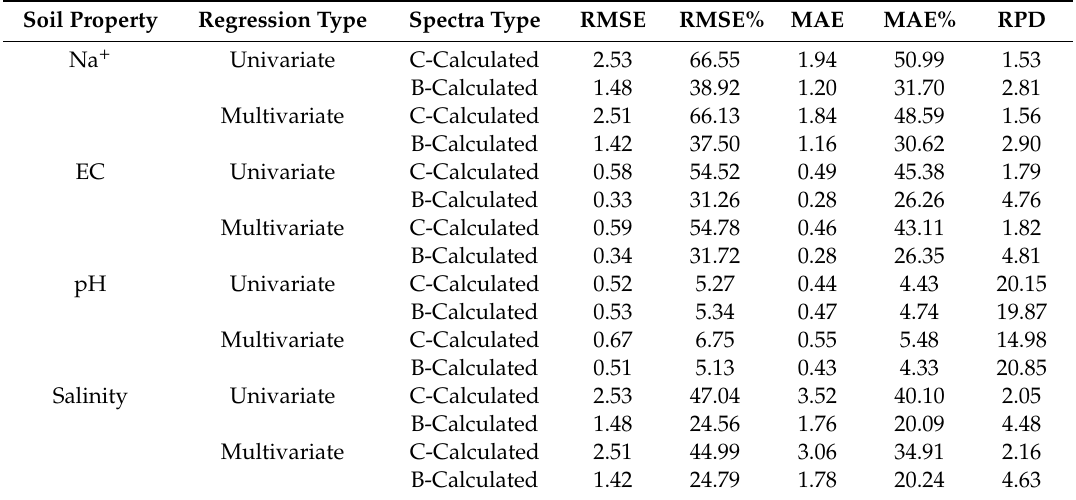
Table 6. Evaluation indexes of the prediction abilities of the regression